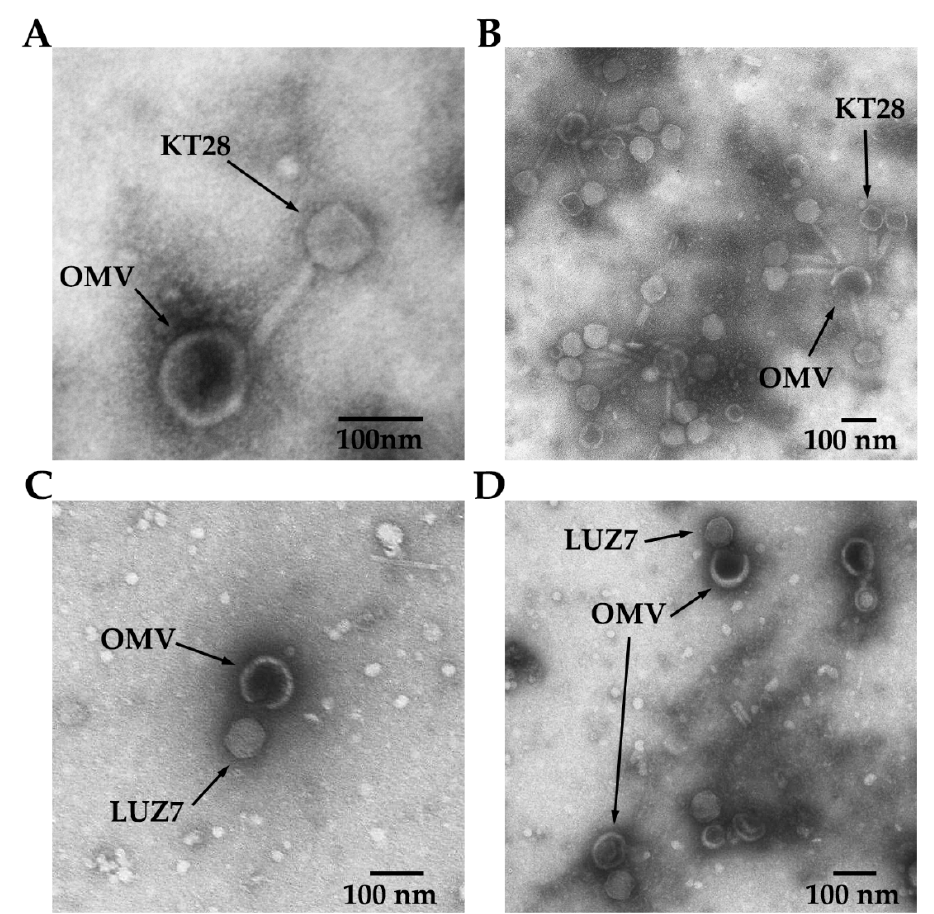
Figure 3. Interactions between OMVs and LPS-dependent phages visualized in TEM technique. ( A ) Adsorption and ( B ) capsid content injection of myovirus KT28; ( C , D ) podovirus LUZ7 adsorption lacking capsid content injection into OMVs interior. Magnifications: ( A ) 50,000×, ( B ) 30,000×, ( C , D ) 16,000×.